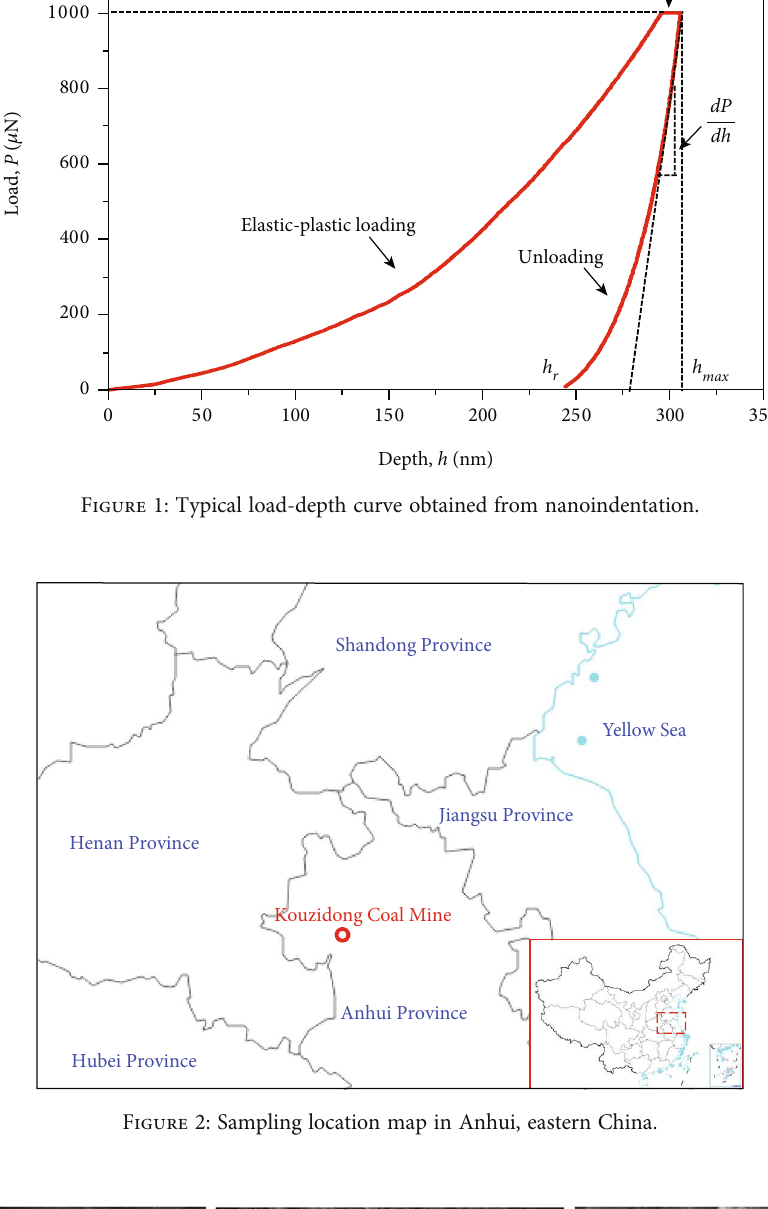
Figure 2: Sampling location map in Anhui, eastern China.